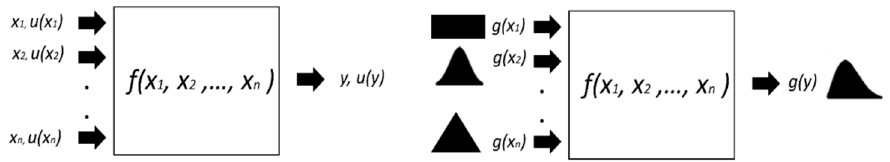
Figure 7. Propagation of uncertainties based on GUM (Guide to the expression of uncertainty in measurement) ( left ); propagation of distributions based on the Monte Carlo method (MCM) ( right ).